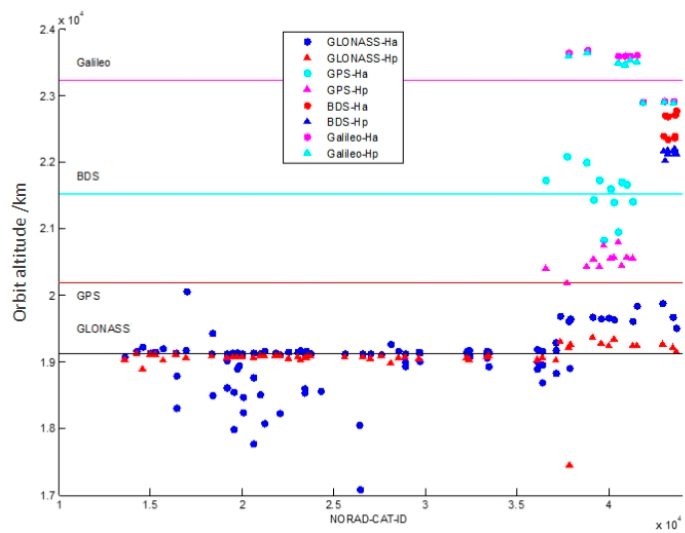
Figure 14. Distributions of spent upper stages in the MEO region.